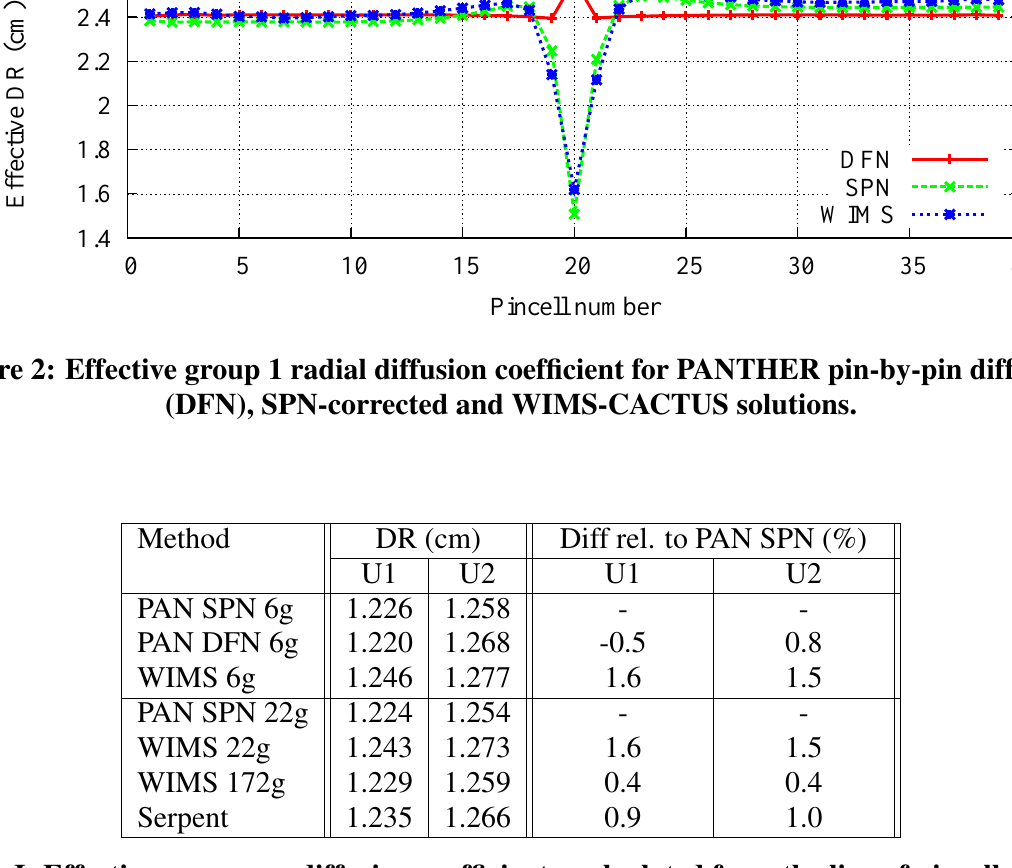
Table I: Effective one group diffusion coefficients, calculated from the line of pincells away from the